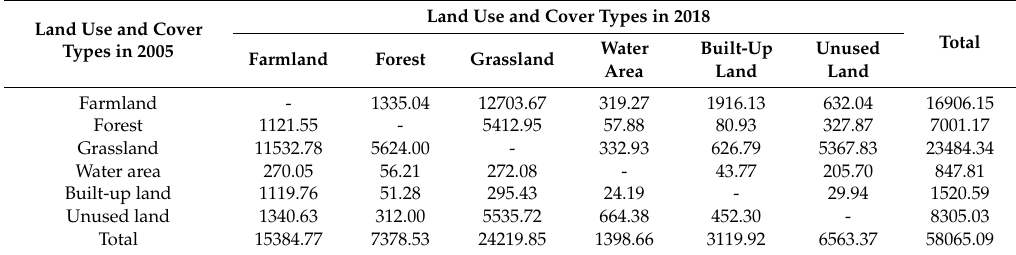
Table 4. Land use and cover conversion matrix from 2005 to 2018 (km 2 ).